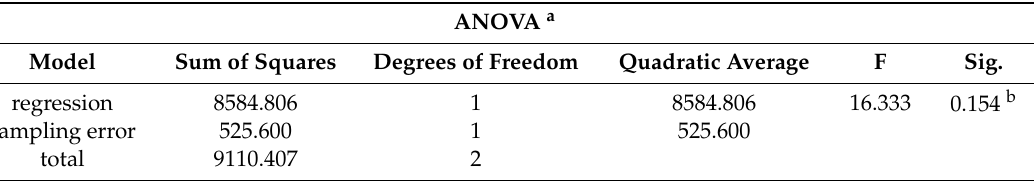
Table 15. Analysis of variance: Wheel-tracking test and second modulus of the plate bearing